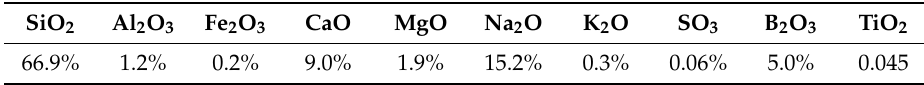
Figure 1. ( a ) Normal appearance of glass wool fibers and ( b ) SEM micrograph of glass wool fibers. Table 3. Chemical composition of glass wool fiber .